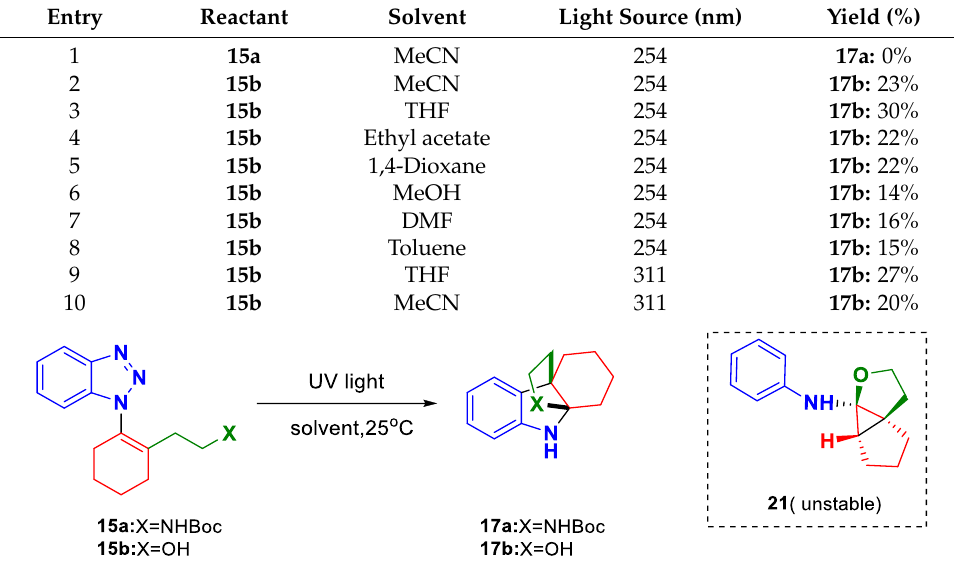
Table 1. Condition optimization of the photoreaction.